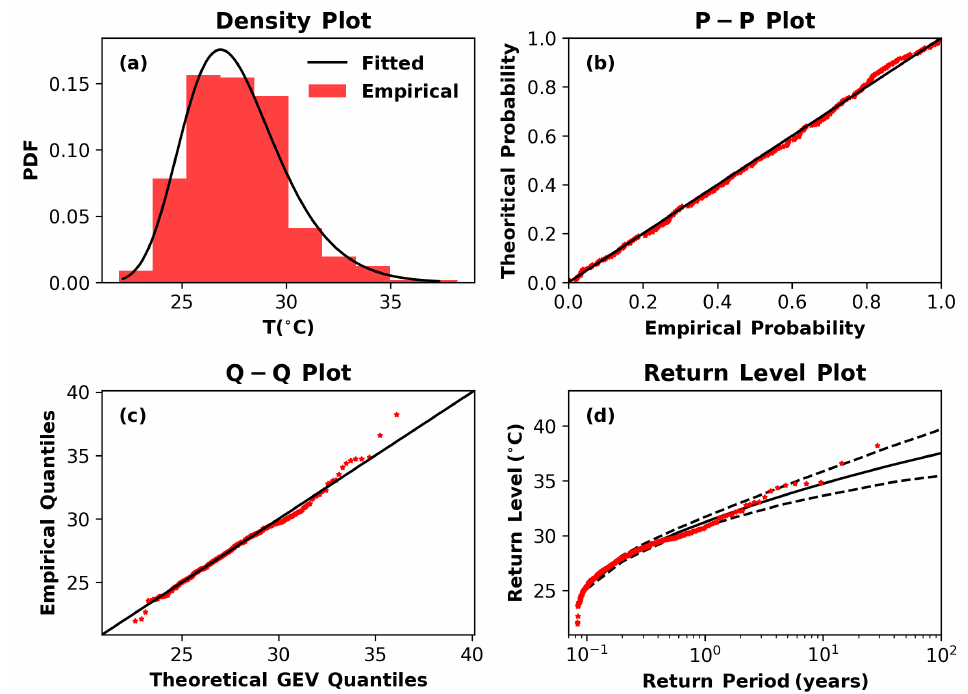
Figure 4. Diagnostic plot for the extreme temperature data of the Crotone station: ( a ) probability density function, ( b ) probability plot, ( c ) quantile plot and ( d ) return level